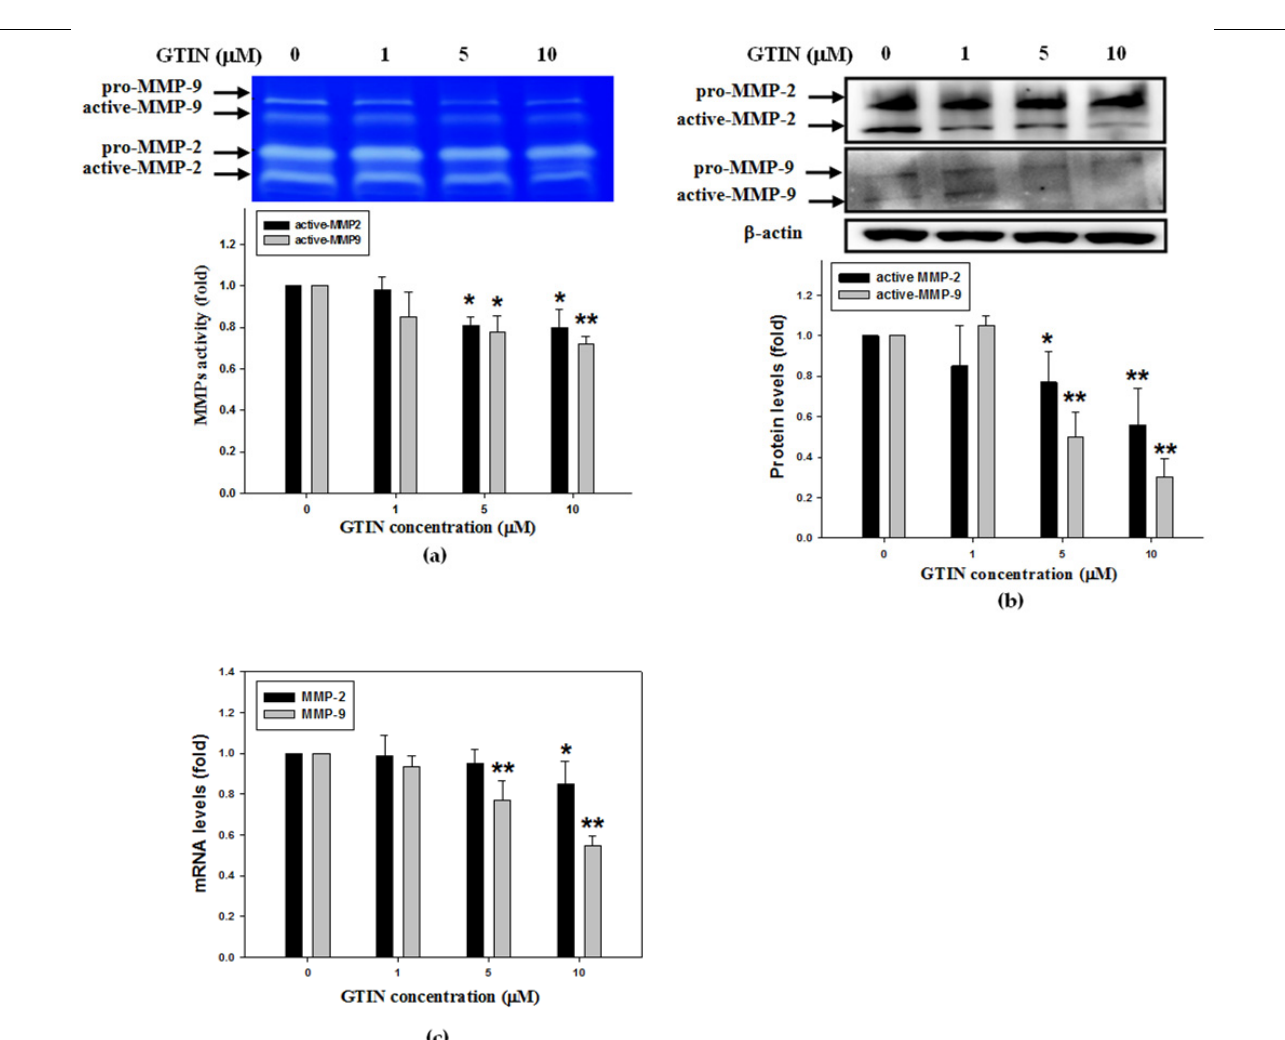
Figure 4. GTIN attenuated the MMP-2/9 activities and expressions in VSMCs. A7r5 cells were incubated with GTIN at the indicated doses (0, 1, 5, and 10 µ M) for 48 h. ( a ) The medium of the treated cells was applied to gelatin zymography to determine the activities of MMP-2/9. The protein levels ( b ) and mRNA levels ( c ) of MMP-2/9 were respectively assayed by WB analysis and qRT-PCR. The results were showed as means ± SD of three repeats from three independent studies. * p < 0.05, ** p < 0.01 compared with the untreated control via one-way ANOVA with Dunnett’s post-hoc analysis.